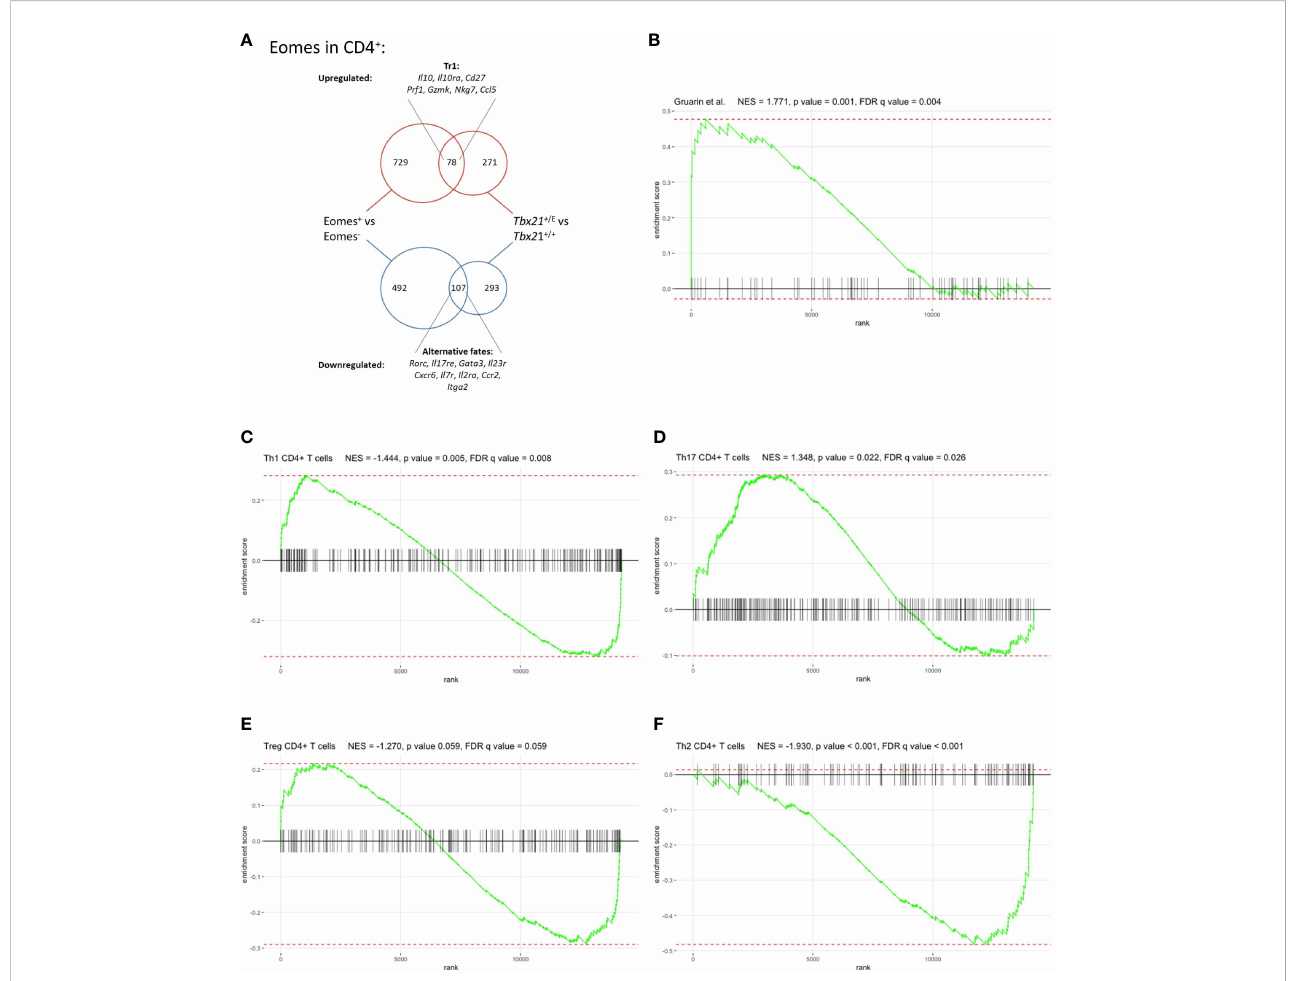
FIGURE 5 Eomes governs a distinct transcriptional pro fi le in CD4 + T cells. (A) Comparison of Eomes-speci fi c gene set with Roessner et al. (11) DEGs of Tbx21 +/+ vs Tbx21 +/E were compared with the DEGs of Roessner et al. Eomes + vs Eomes - CD4 + T cells after expansion in Rag2 -/- mice. Of the 78 up- and 107 downregulated genes differentially expressed in both studies selected genes are shown (Full list in Supplementary Table 5). (B-E) GSEA of T helper cell subset gene signatures compared with differences in gene expression between CD4 + SMARTA T cells from Tbx21 +/E and Tbx21 +/+ , (B) a set of genes upregulated in human IL-10-secreting IL-7r - CD4 + T cells, derived from Gruarin et al. (10), (C-F) sets of upregulated genes in (C) Th1, (D) Th17, (E) Treg and (F) Th2 CD4 + T cells, as detailed in the text. The enrichment score (ES) is shown on the y-axis and the x-axis represents the sorted list of genes in our comparison. Genes that are present in the respective gene set are shown by vertical black